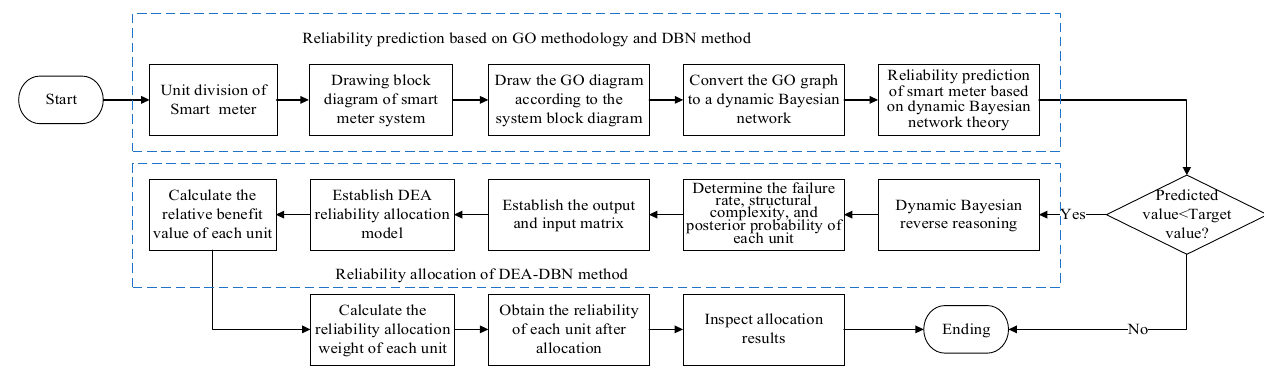
Figure 3. Reliability allocation